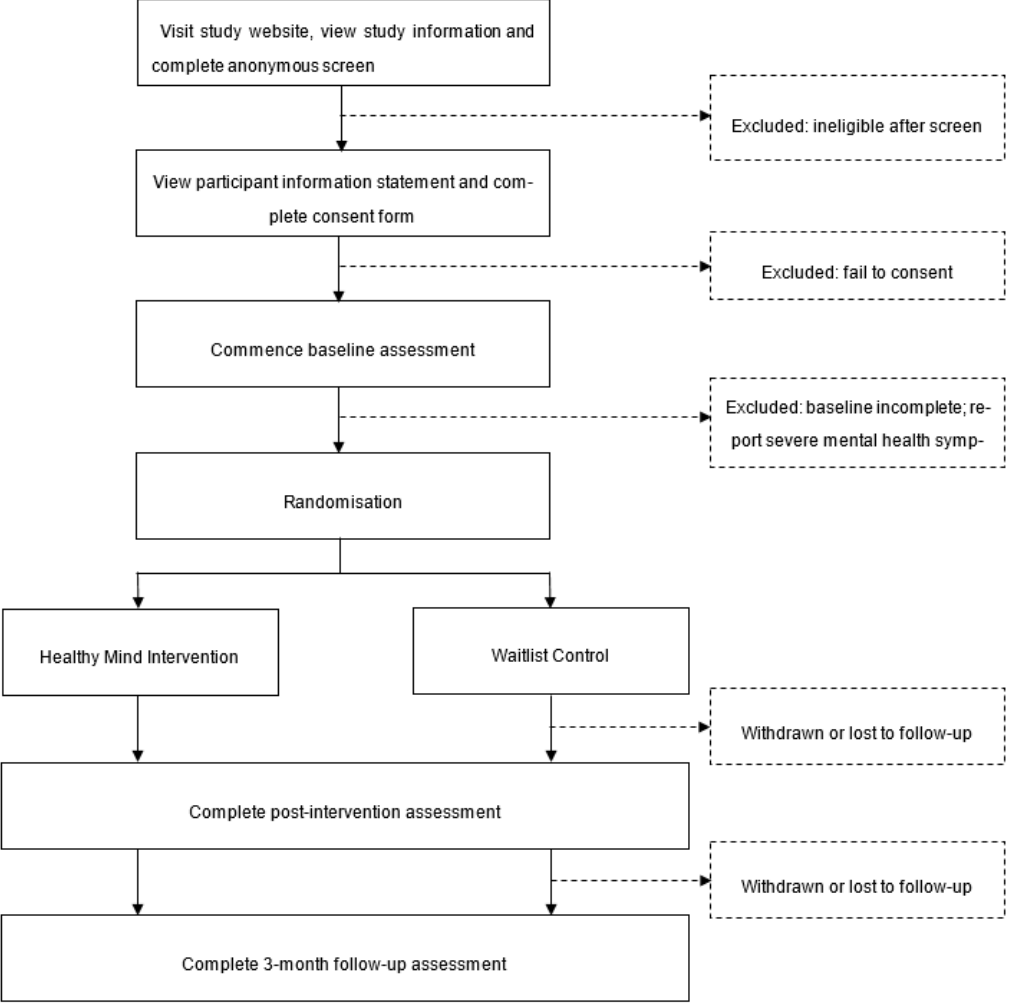
Figure 4. Healthy Mind CONSORT diagram.